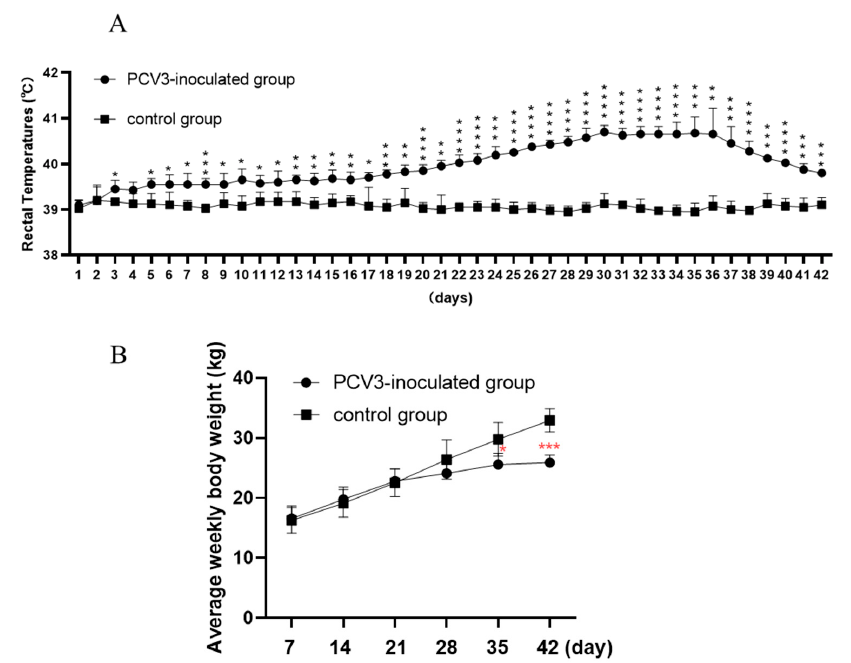
Figure 1. The daily rectal temperature ( A ) and average weekly body weight ( B ) in the control group and PCV3-inoculated group. * means p < 0.05, ** means p < 0.01, *** means p < 0.005, **** means p < 0.0001 when compare PCV3-inoculted group with control group.